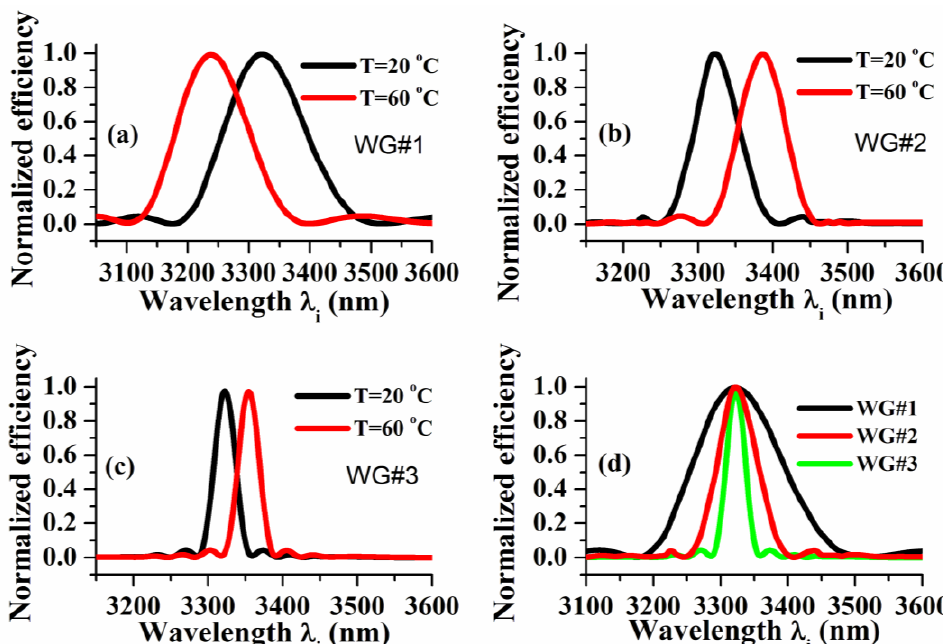
Figure 11. Phase matching curves of three different periodically poled TF-LN-on-sapphire rib waveguides—( a ) WG#1, ( b ) WG#2 and ( c ) WG#3—calculated at two different temperatures: T = 20 and 60 o C; ( d ) a comparison of phase matching curves of three waveguides—WG#1, WG#2 and WG#3—at 20 o C, which are taken from ( a – c ).